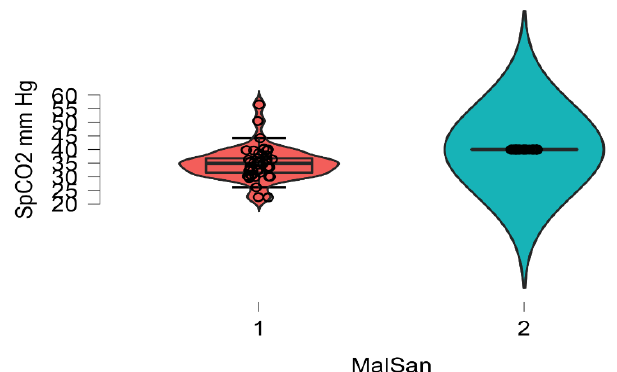
Figure 2. Boxplots of SpCO2 in mm/Hg concentrations in COVID-19 patients (red) and healthy control (blue) cases stratified by SpCO 2 concentration. Of note, COVID-19 status ( p = 0.005) and SpCO 2 ( p < 0.001) are significantly associated with clinical values in a multivariable linear regression analysis of sex, age, and COVID-19 status.